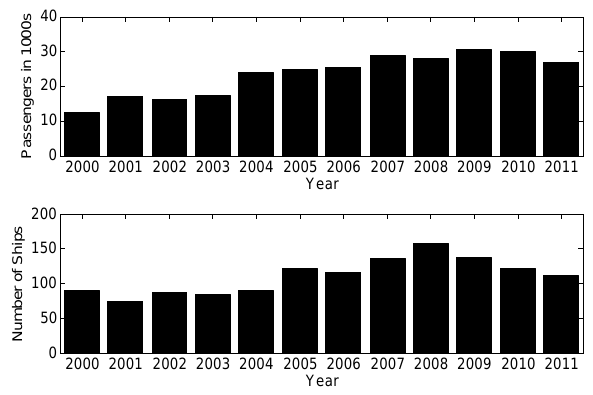
Fig. 2. Total number of ship passengers visiting Ny Ålesund per year (upper panel) and number of ships registered in the Ny Ålesund harbor log (lower